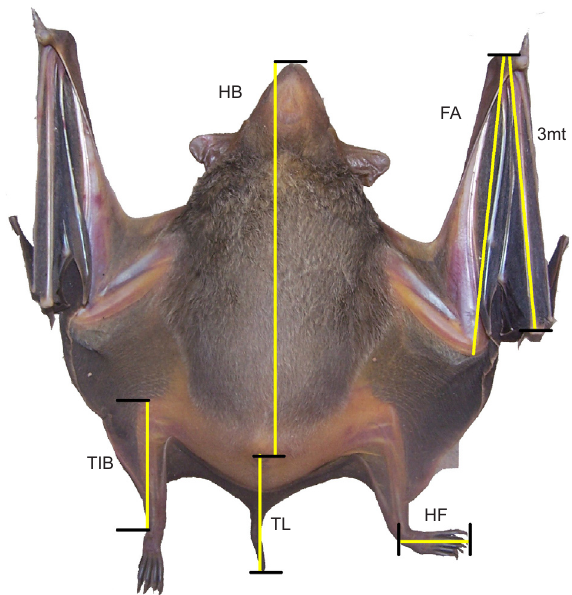
Figure 3b. Important external measurements of Taphozous